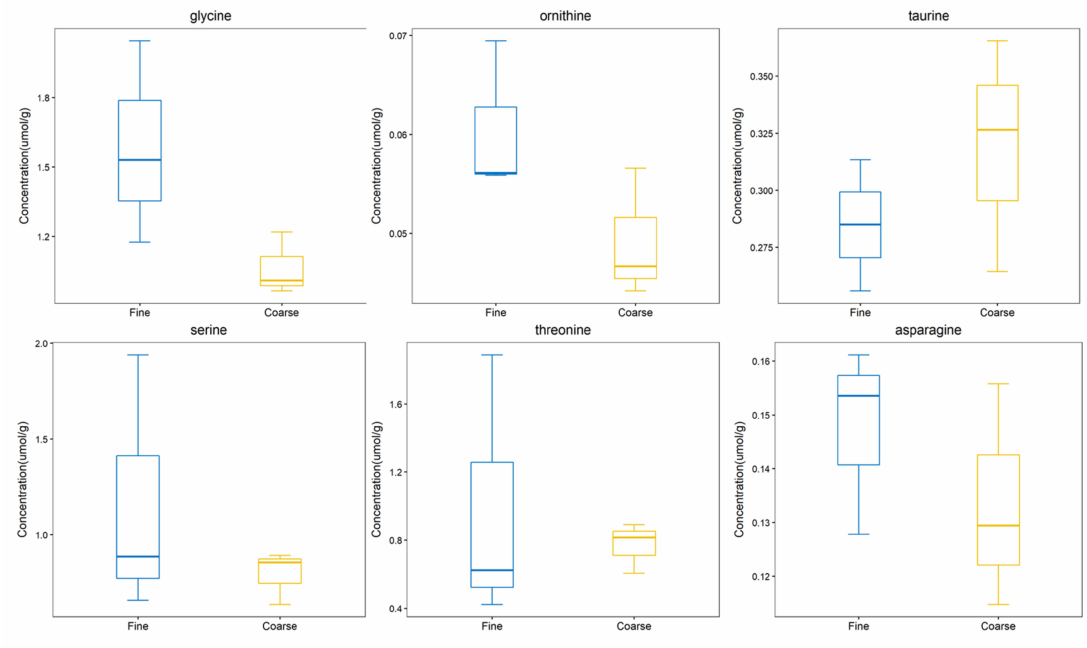
Figure 12. Trend map of metabolite